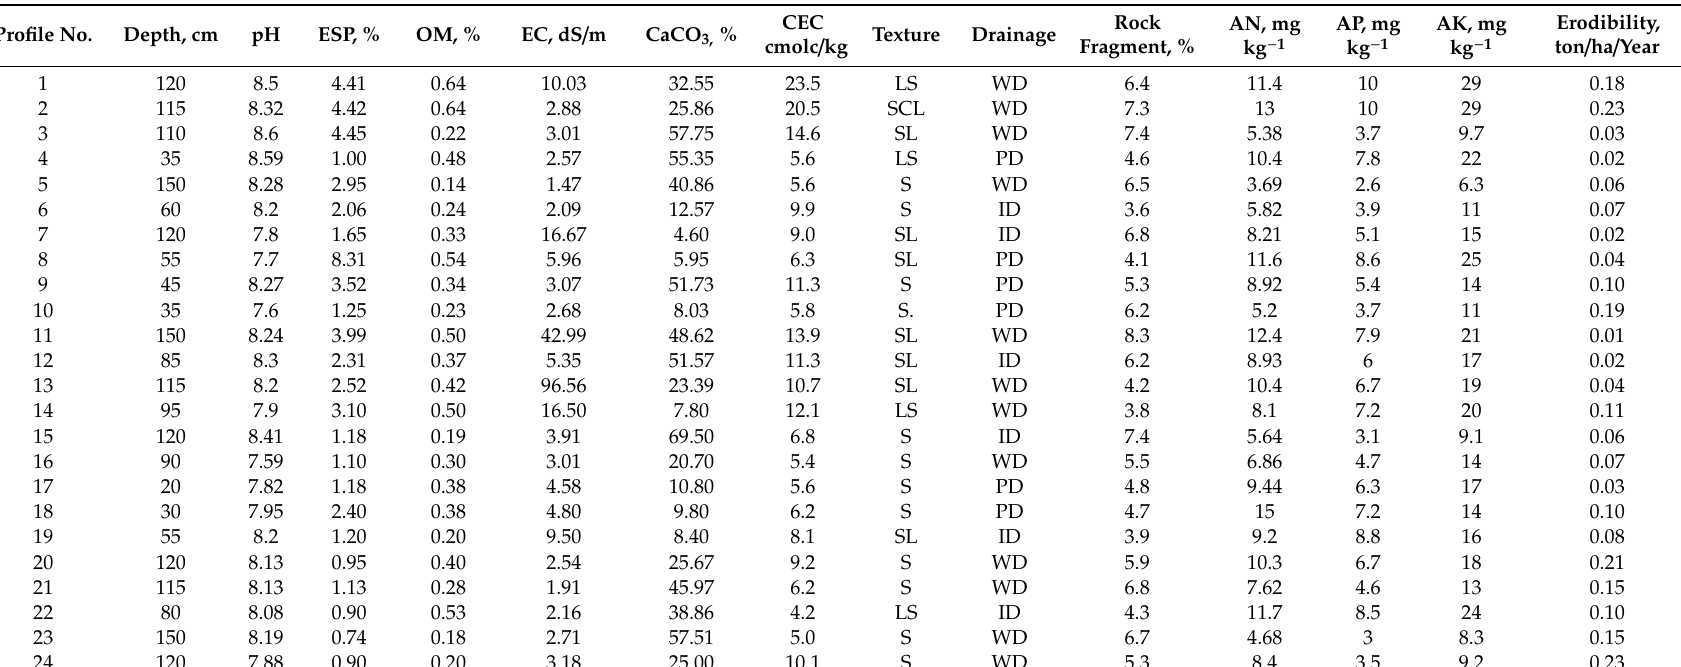
Table 1. The variation of soil characteristics for each geomorphic unit of the study